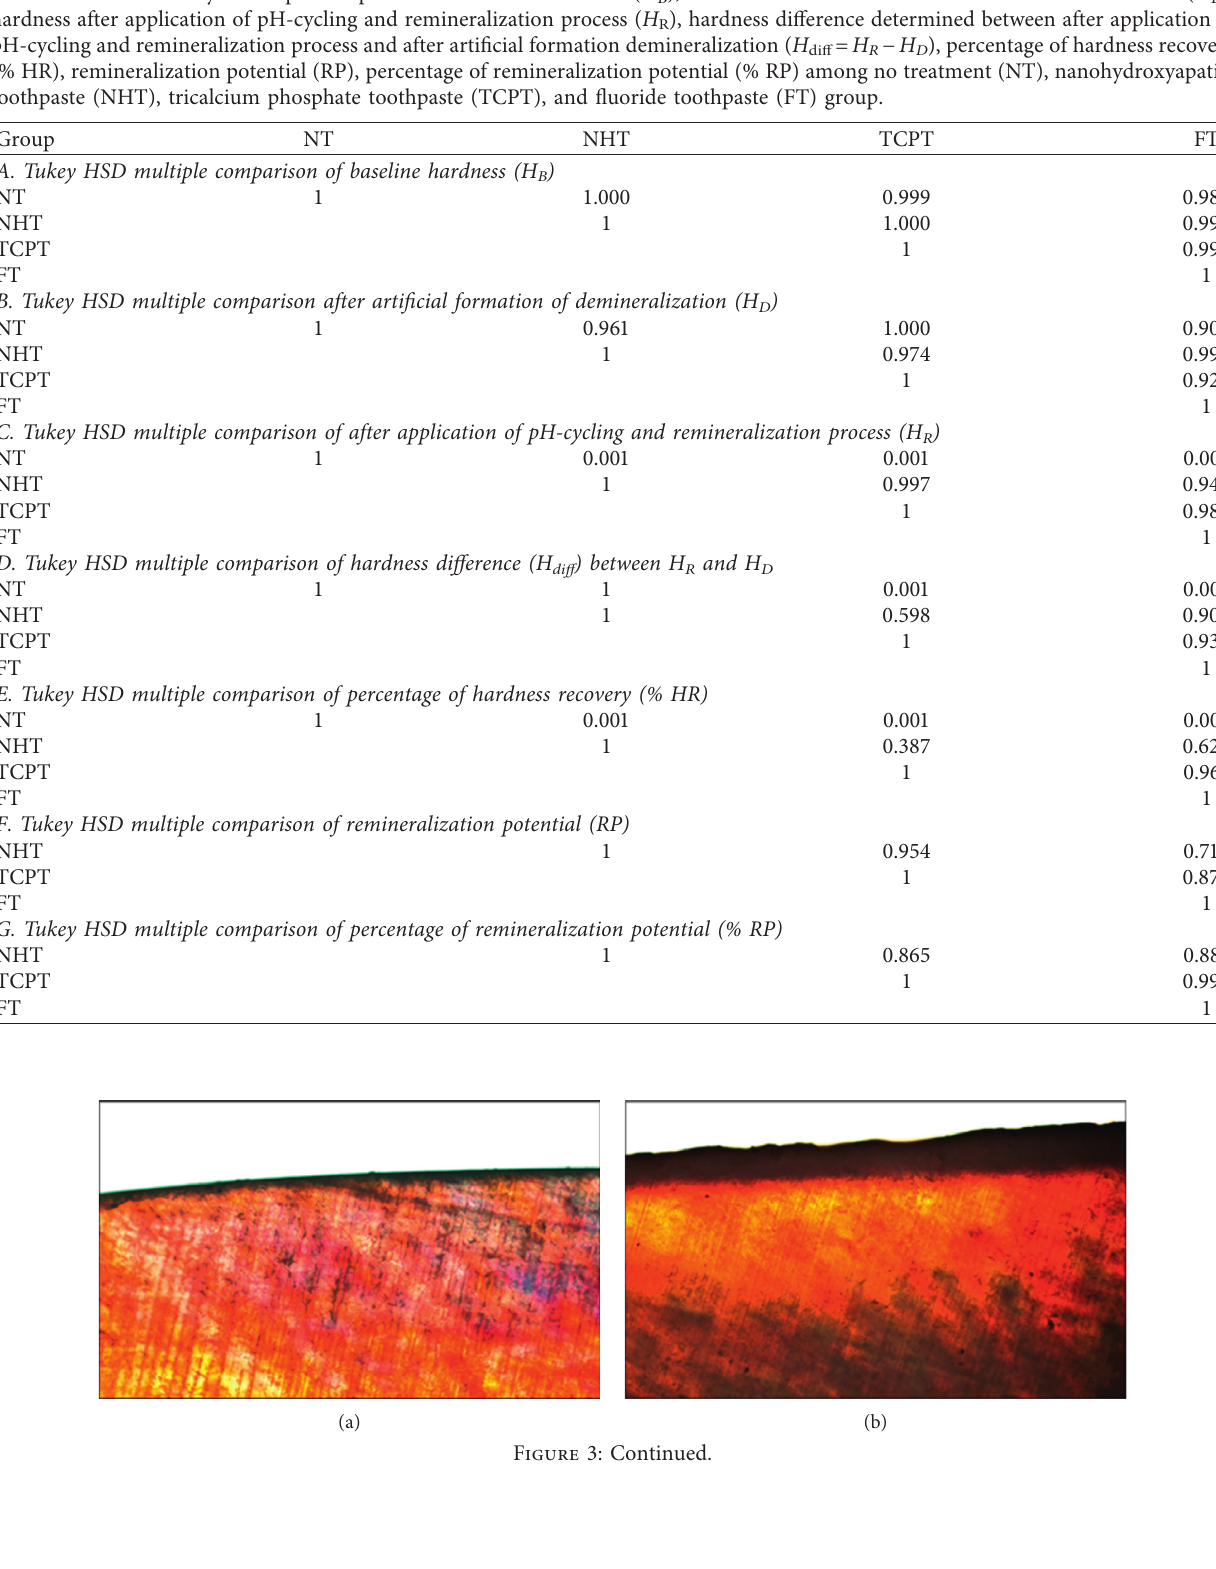
B ), hardness after artificial formation of demineralization ( H D